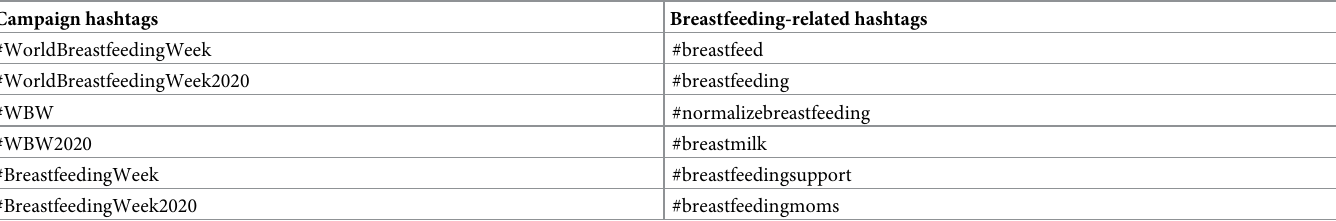
Table 1. Hashtags used to capture tweets related to the campaign as well as breastfeeding-related conversations during the six months prior to the 2020 World Breastfeeding Week campaign. Campaign